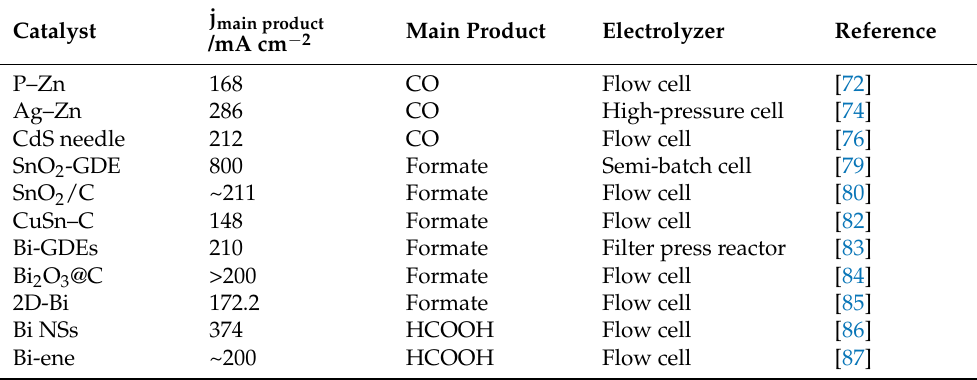
Table 4. CO 2 electroreduction performances of other non-noble